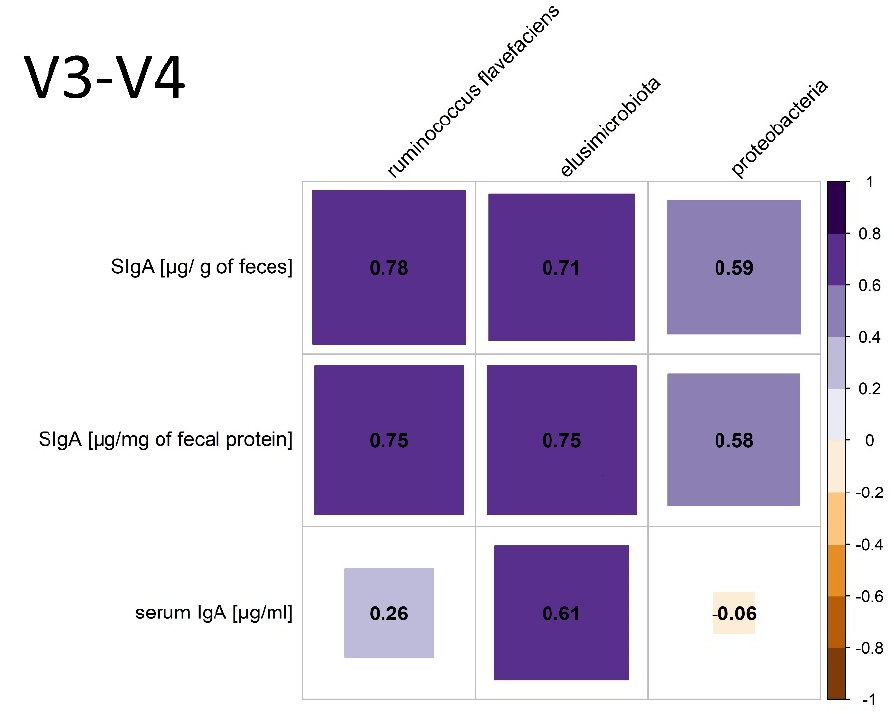
Figure 3. Relationships between important phyla and species and the level of SIgA in the feces and IgA in the serum. p < 0.05.